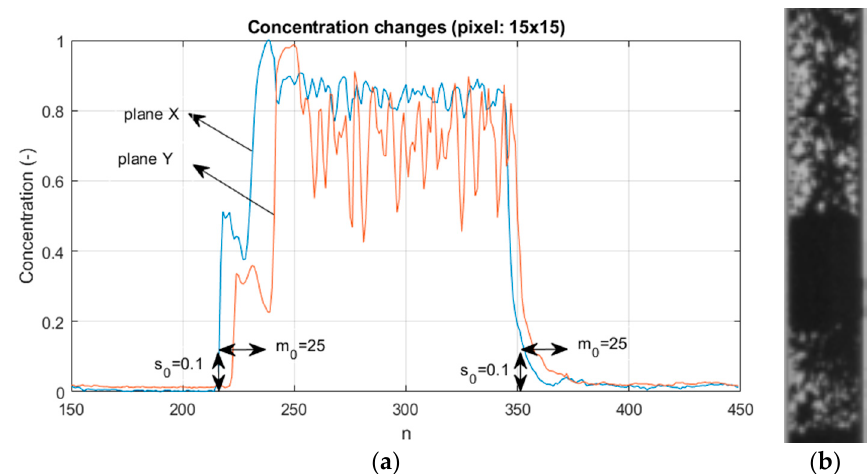
Figure 2. Normalized concentration changes within a chosen pixel (15,15) of the tomographic images ( a ) and the image captured by a high speed camera (#220–#320) ( b ); s 0 — some threshold level and m 0 — the arbitrarily chosen number of frames.